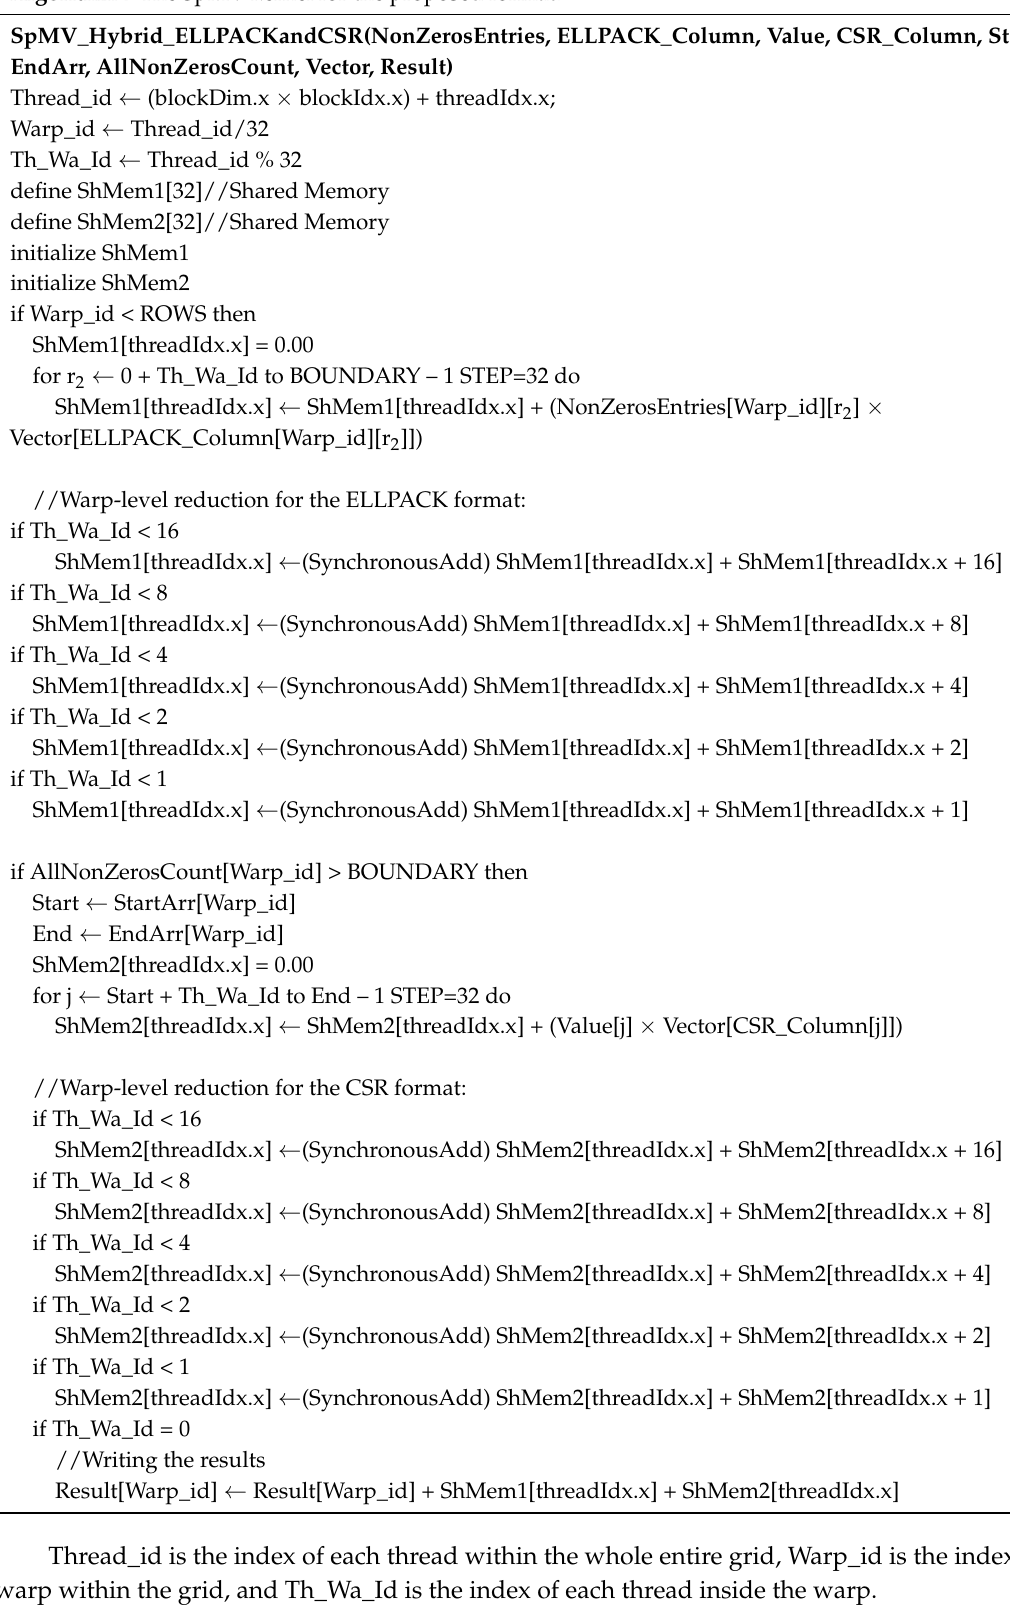
Algorithm 7 The SpMV kernel for the proposed